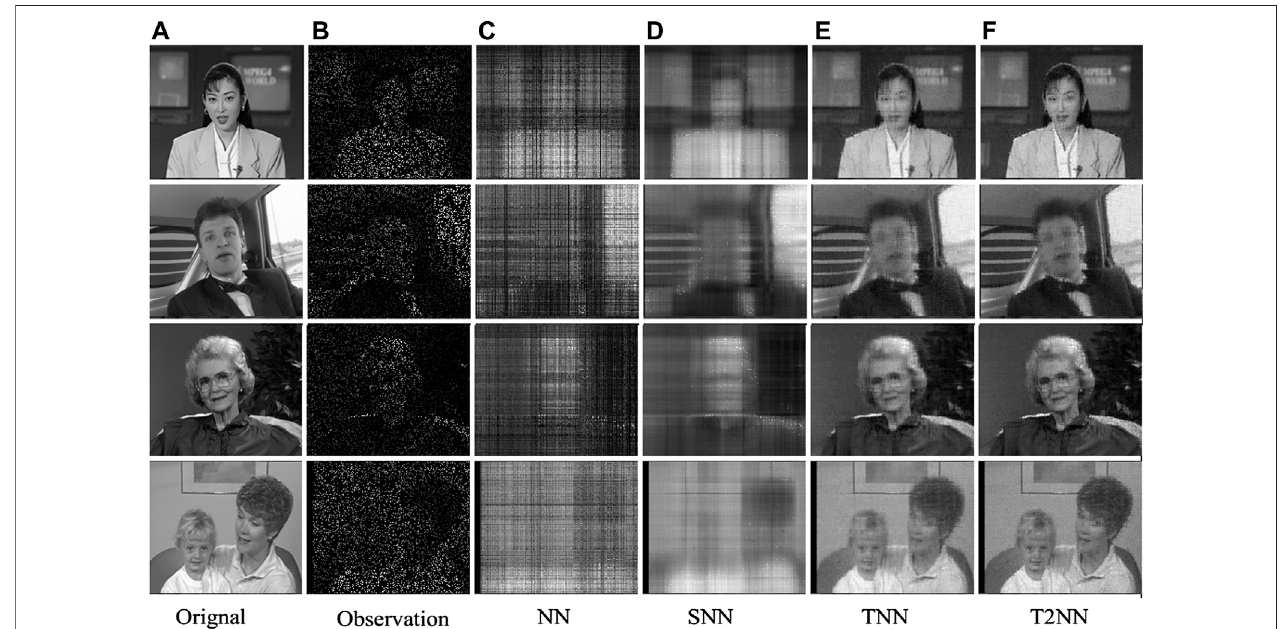
FIGURE 3 | Visual results obtained by four norms for noisy tensor completion with 95% missing entries on the YUV-video dataset. The fi rst to fourth rows correspond to the video of Akiyo, Carphone, Grandman, and Mother-duaghter, respectively. The sub-plots from (A) to (F) : (A) a frame of the original video, (B) the observed frame, (C) the frame recovered by NN [30], (D) the frame recovered by SNN [22], (E) the frame recovered by the vanilla TNN [25], and (F) the frame recovered by our T2NN.